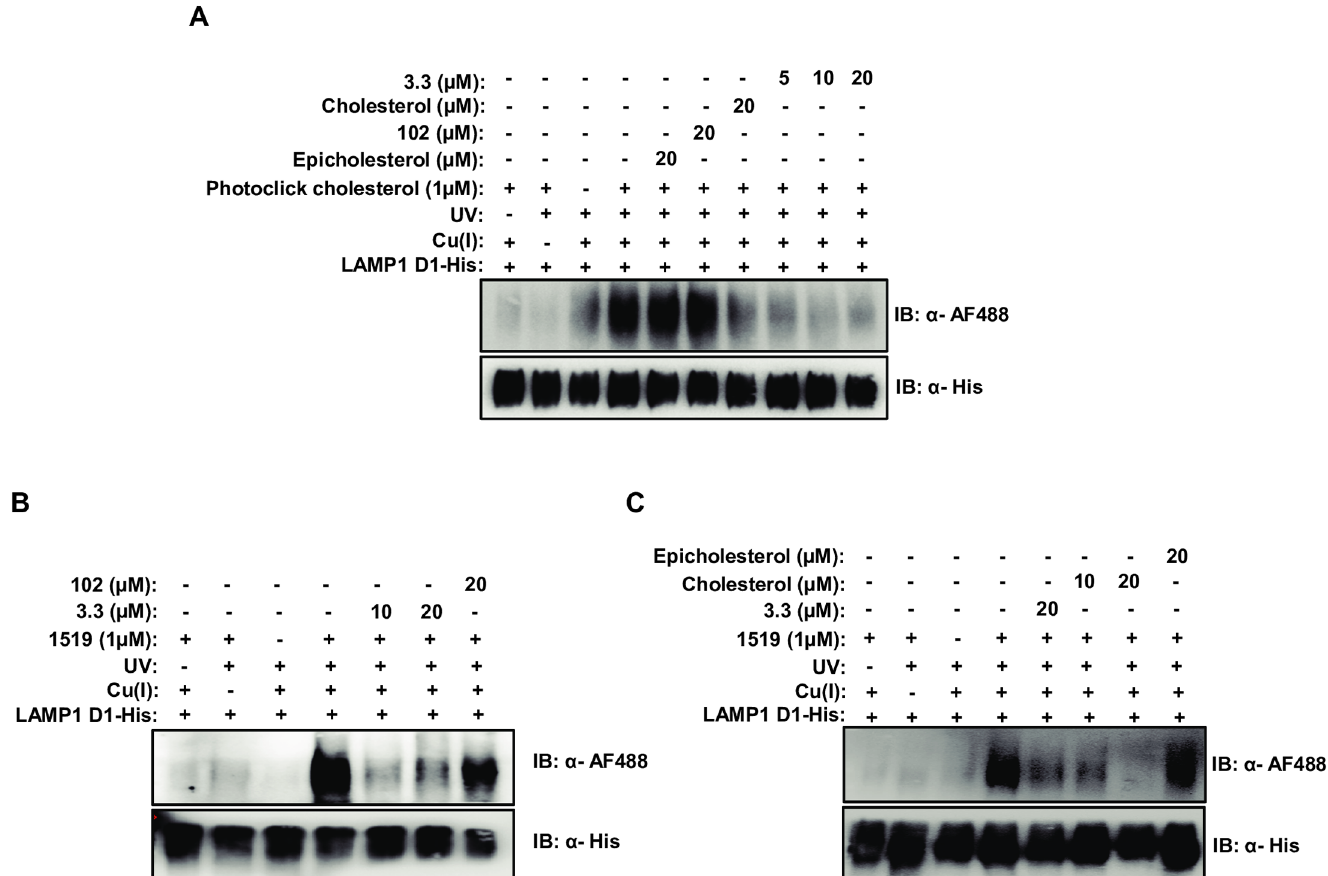
Fig 4. Cross-linking of 1519 to LAMP1 D1 is inhibited by cholesterol and vice versa. (A) A photoreactive cholesterol analog (photoclick cholesterol) cross-linking to purified LAMP1 D1 is competed by a molar excess of cholesterol or 3.3 but not by a molar excess of epicholesterol or 102. Purified LAMP1 D1-His was incubated with the indicated compounds for 1h at 37˚C prior to UV irradiation and click chemistry with an AF 488 azide. Labeled protein was detected by immunoblot with an anti-AF 488 antibody. Input LAMP1 D1 was detected using an anti-His antibody. (B) 1519 cross-links to purified LAMP1 D1 in a manner which is competed by a molar excess of 3.3 but not the inactive derivative, 102. Purified LAMP1 D1-His was incubated with the indicated compounds for 1h at 37˚C prior to UV irradiation and click chemistry with an AF 488 azide. Labeled protein was detected by immunoblot with an anti-AF 488 antibody. Input LAMP1 D1 was detected using an anti- His antibody. (C) 1519 cross-links to purified LAMP1 D1 in a manner which is competed by a molar excess of 3.3 and cholesterol but not epicholesterol. Purified LAMP1 D1-His was incubated with the indicated concentrations of 1519 and 3.3, cholesterol or epicholesterol for 1h at 37˚C prior to UV irradiation and click chemistry with an AF 488 azide. Labeled protein was detected by immunoblot with an anti-AF 488 antibody and input LAMP1 D1 was detected using an anti-His antibody.